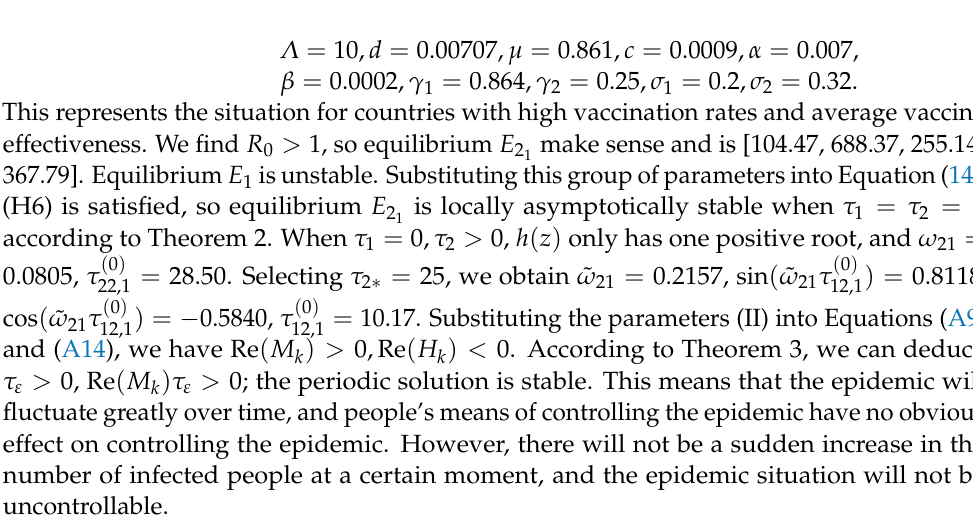
of System (1) is locally asymptotically 1